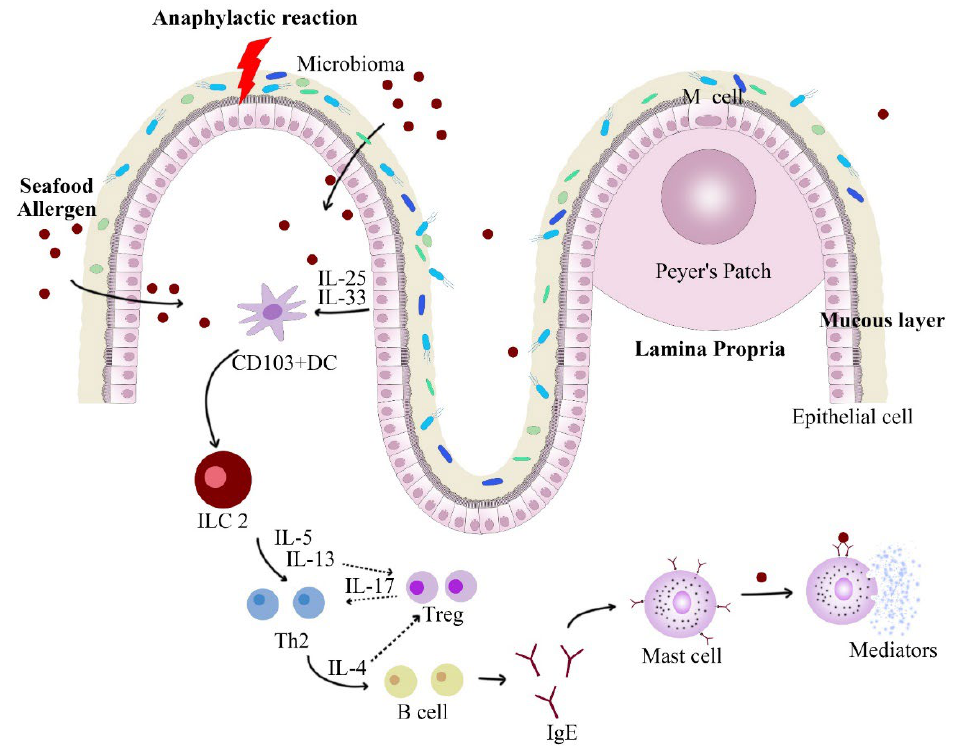
Figure 3. Main mechanisms by which the breakdown of tolerance to food antigens can occur. When food allergens stimulate the mucosal system, the damaged epithelial cells will secrete cytokines, such as IL-33, to induce the differentiation of ILC 2 into Th 2, and secrete related cytokines, such as IL-13. Il-4 inhibits the differentiation of ILC 2 into Treg, ultimately leading to the production of allergen-specific IgE. IgE binds to Fc ε R I fragments on mast cells to activate mast cell release mediators and induce food allergy symptoms.